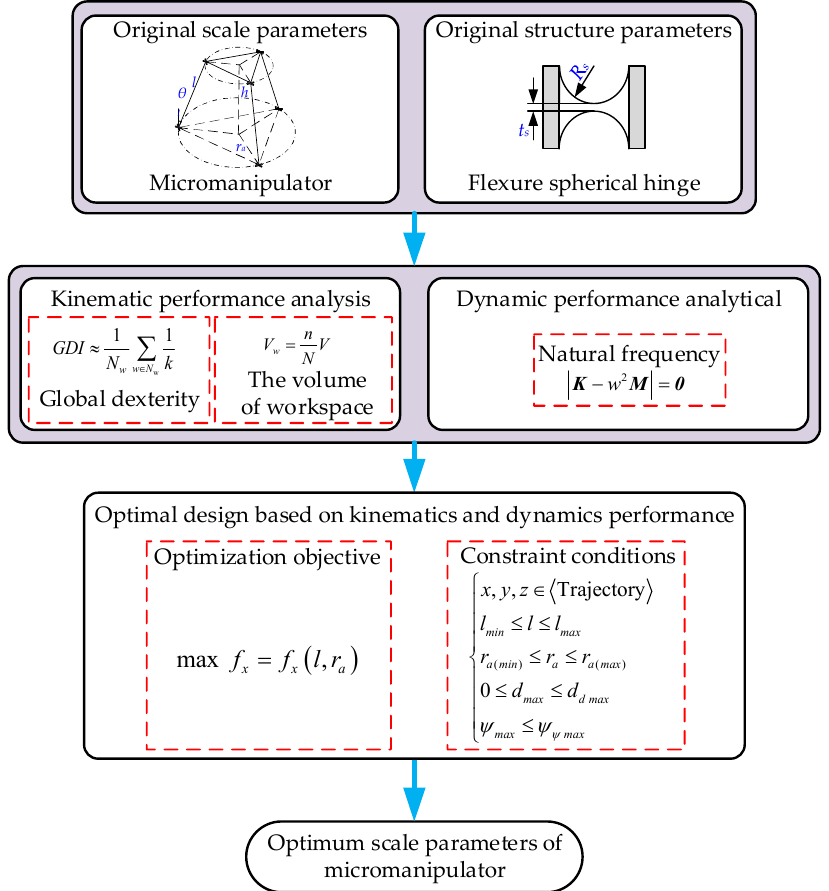
Figure 13. The synchronous optimization procedure based on kinematics and dynamics